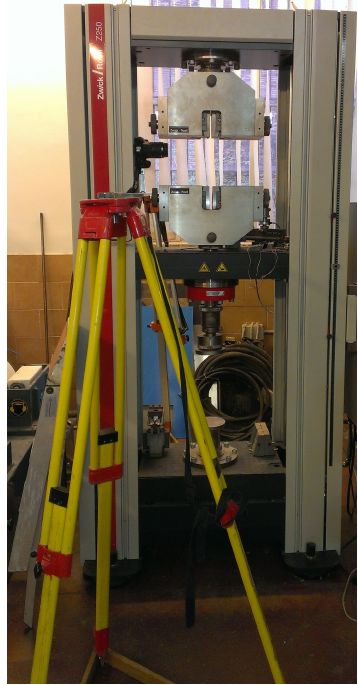
Figure 3: The experimental setup: the testing machine and the camera.